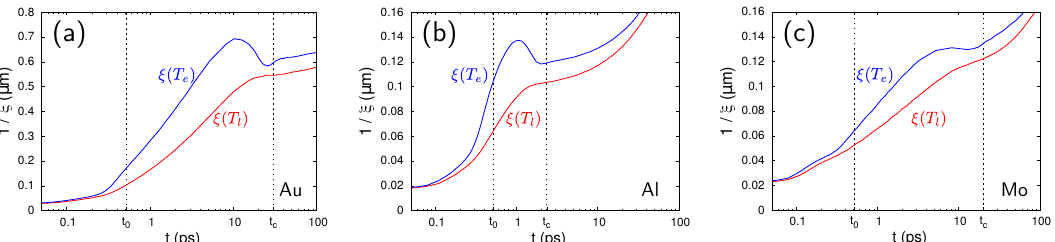
Figure 2. Evolution of the characteristic in-depth lengths (1/ ξ ) of the temperature profiles for lattice (red) and electrons (blue) calculated for Au ( a ), Al ( b ), and Mo ( c ). Vertical dashed lines mark the end of the laser pulse and the electron–phonon coupling time determined here as the time when the T e ( t ) and T l ( t ) curves cross ( ∼ 30ps for Au, ∼ 2ps for Al, and ∼ 20ps for